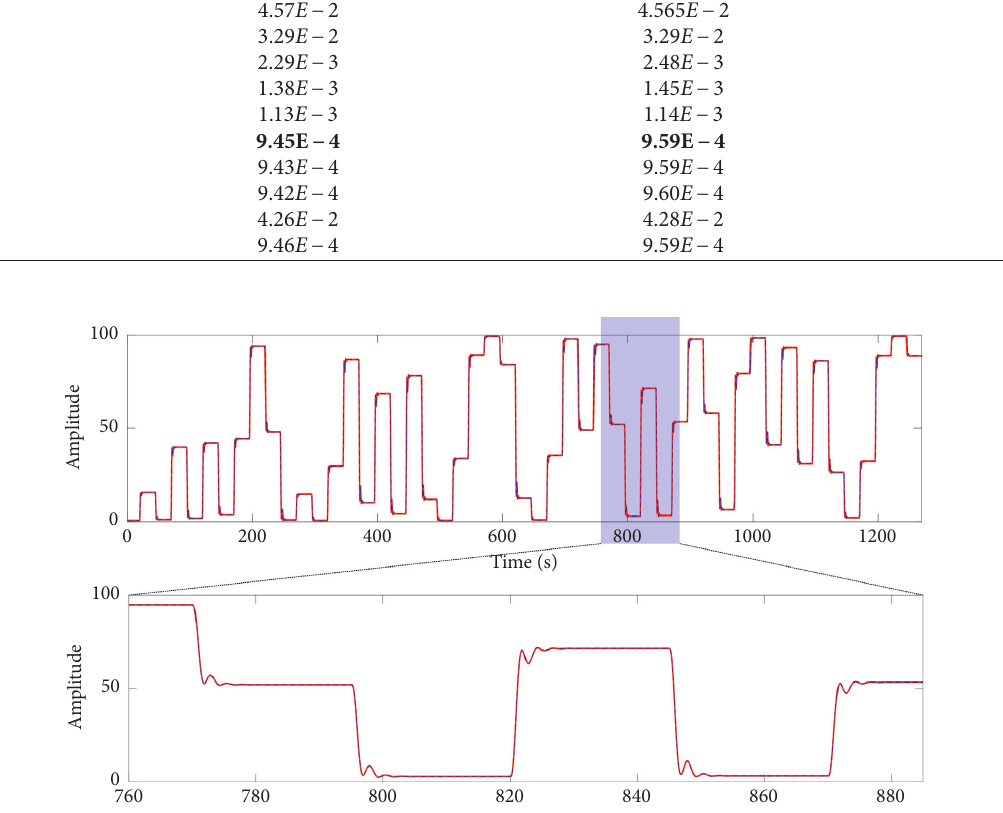
Figure 14: Validation results for numerical example 2: real output (red solid line) and model output (blue dashed